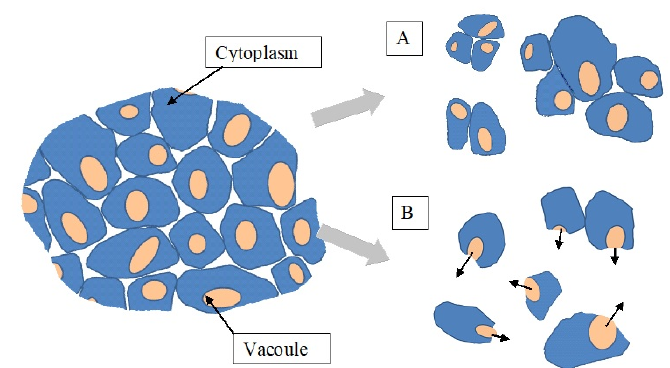
Figure 5. Chart illustrating fruit tissue disruption: ( A ) soft varieties; ( B ) hard varieties.